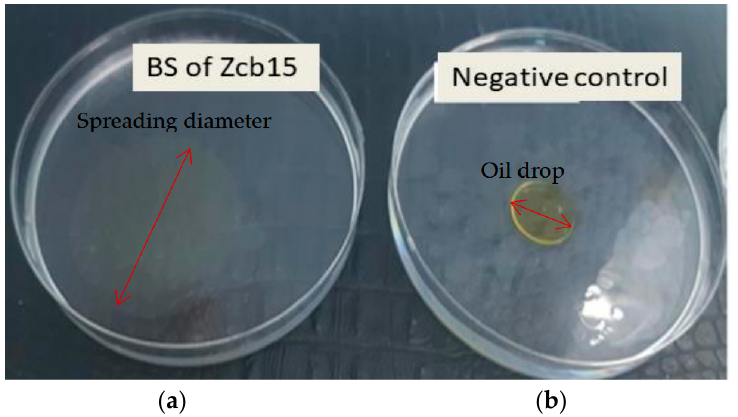
Figure 3. Oil spreading method observed in the Petri dishes of a sample containing the biosurfactant solution of strain Zcb15 ( a ) as compared to the negative control (distilled water and oil) ( b ).